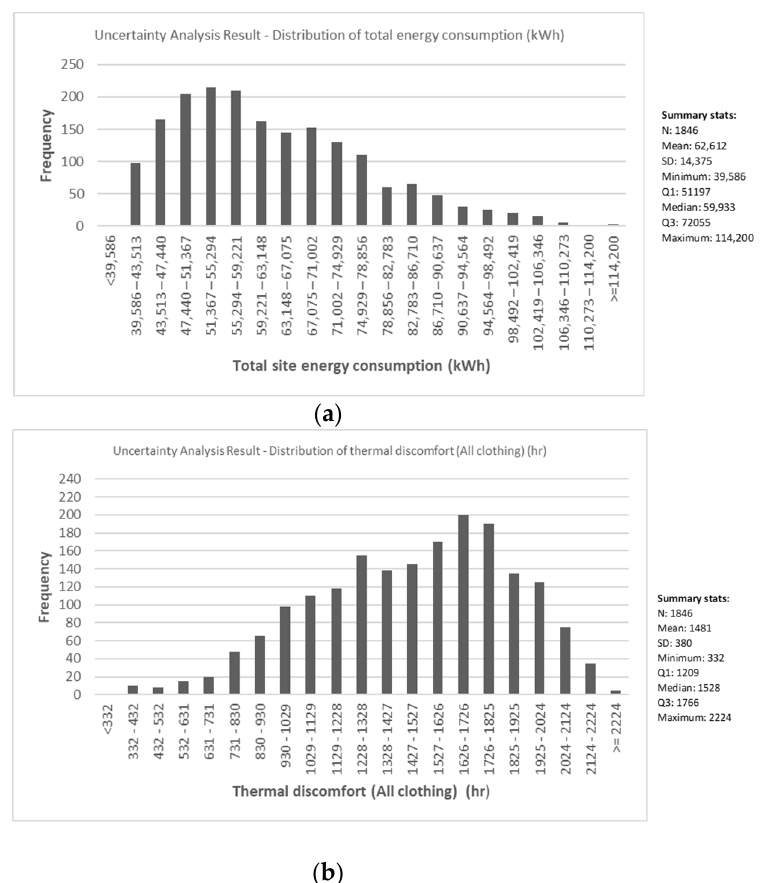
Figure 4. UA results ( a ) distribution of total energy consumption. ( b ) Distribution of total thermal discomfort hours.